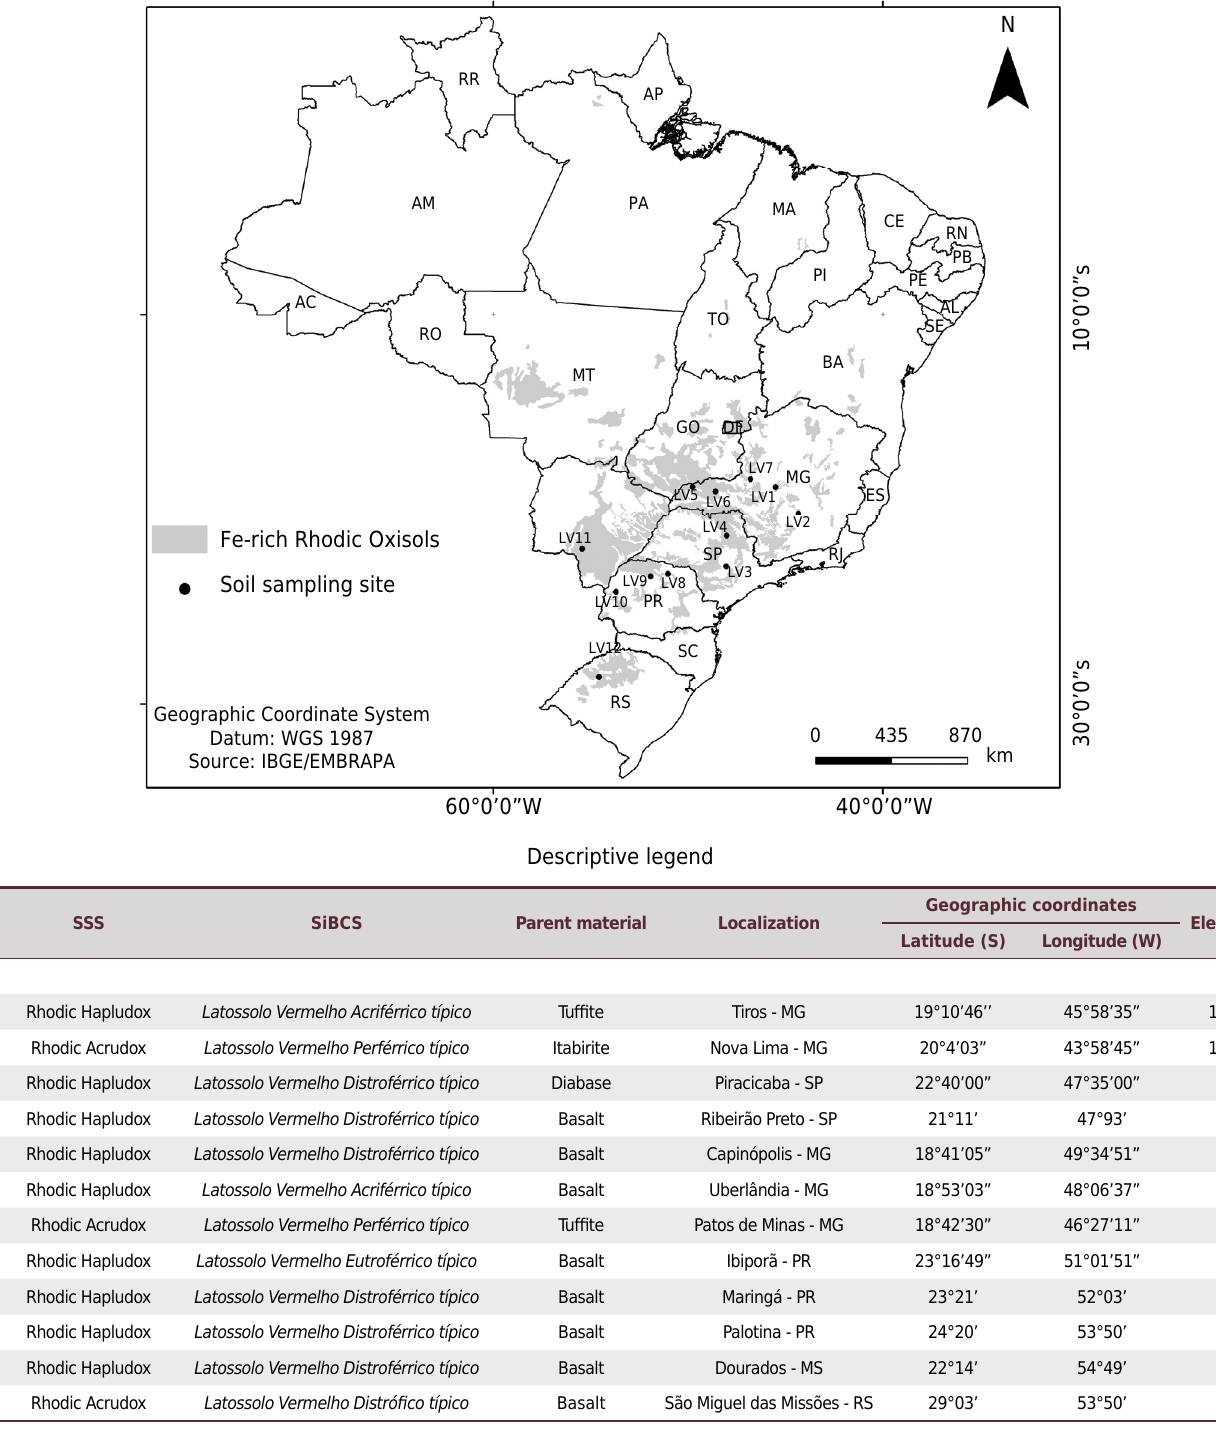
Figure 1. Distribution map of Rhodic Oxisols in Brazil with geographic coordinates, parent rock materials and classification according to the Soil Taxonomy (Soil Survey Staff, 2014) and Brazilian Soil Classification System – SiBCS (Santos et al.,